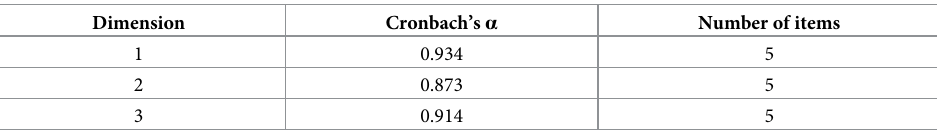
Table 2. Reliability